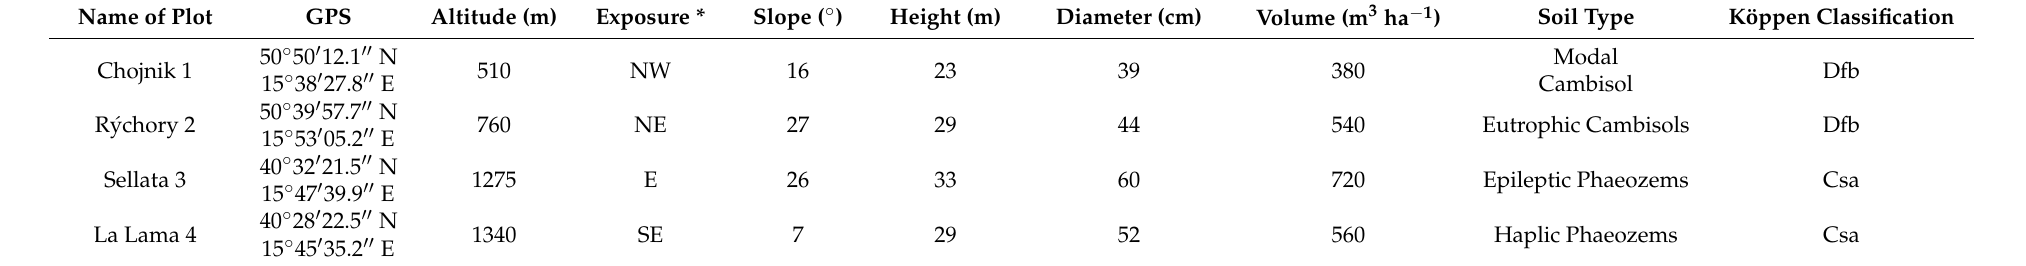
Table 1. Overview of basic site and stand characteristics of research plots in